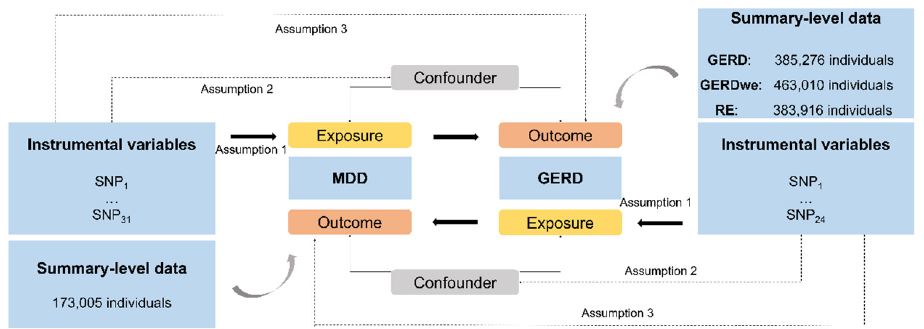
Figure 1. The present study design overview. All individuals are of European ancestry. MDD, Major Depressive Disorder; GERD, gastroesophageal reflux disease; SNP, single-nucleotide polymorphism.